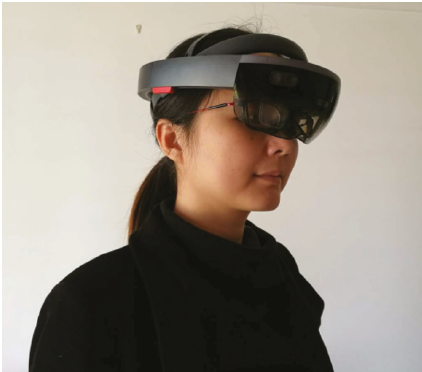
Figure 7: A participant using Microsoft Hololens to perform a search task using the open speakers on the Hololens.